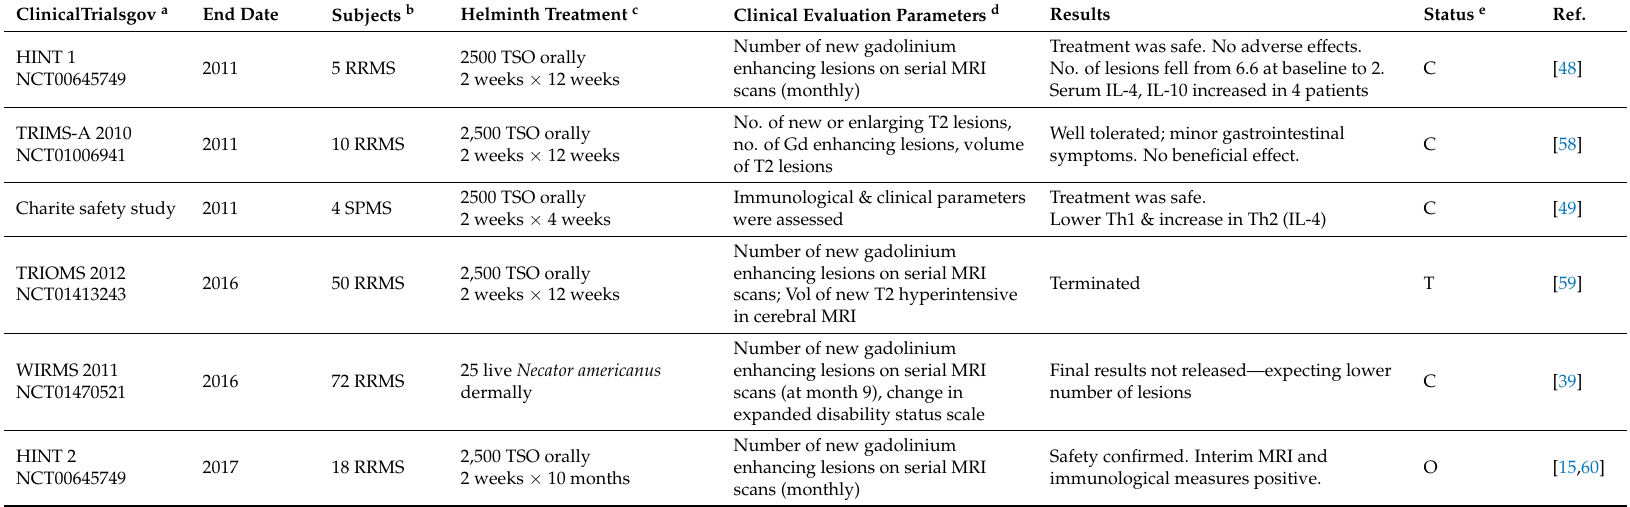
Table 2. Human clinical trials of live helminth infection as a therapeutic for Multiple